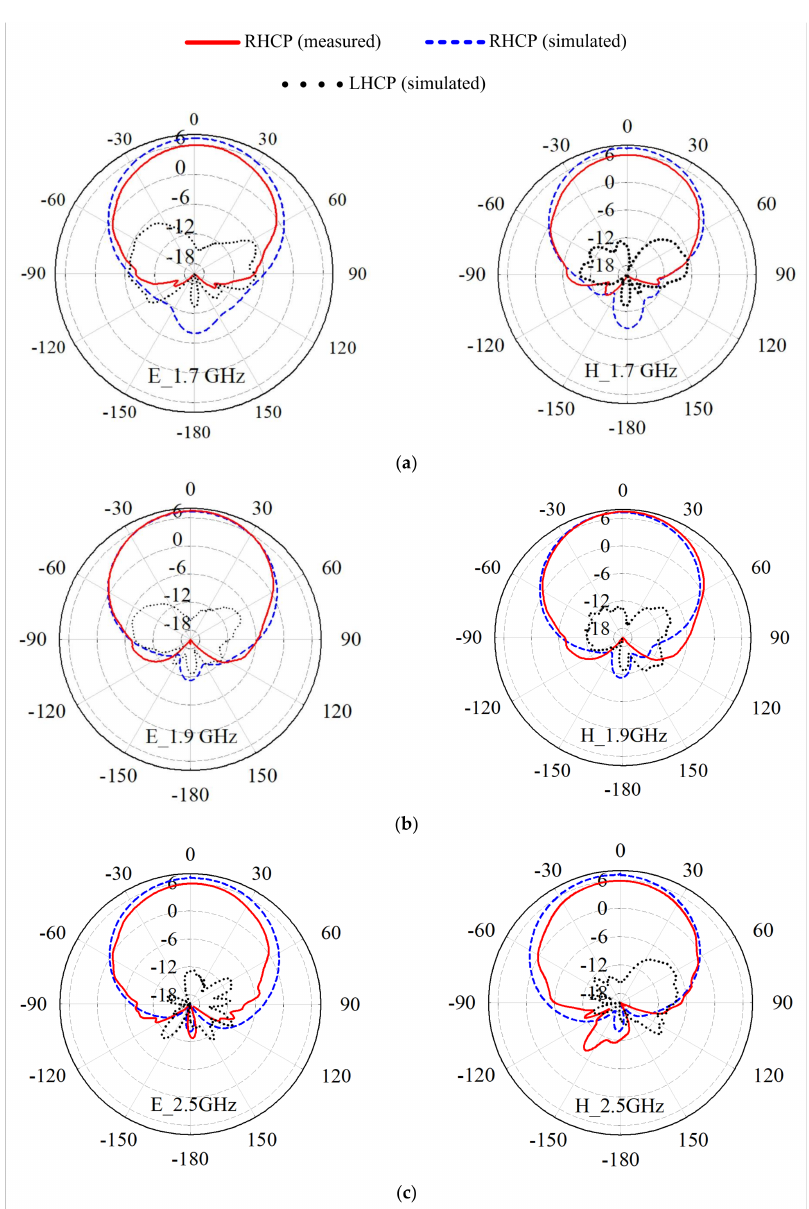
Figure 10. Experimental results of the proposed PCD antenna: ( a ) Reflection coefficients and port-to-port isolation. ( b ) Axial ratio and gain.